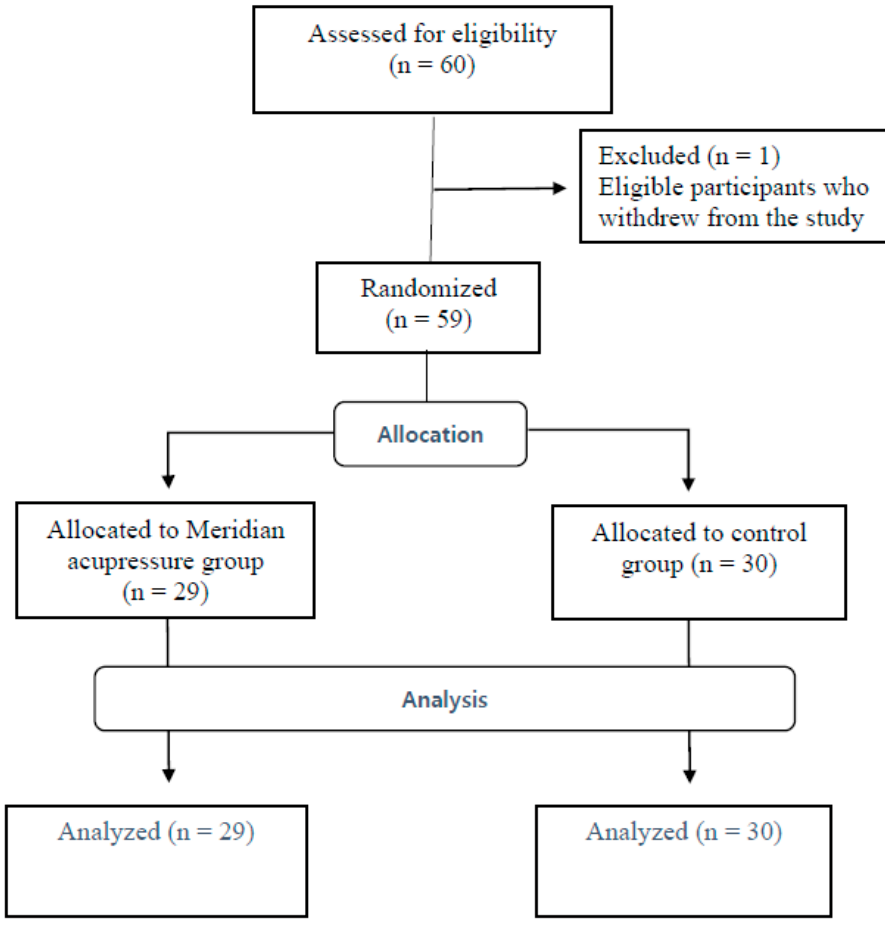
Figure 1. Flow diagram of subject progress.